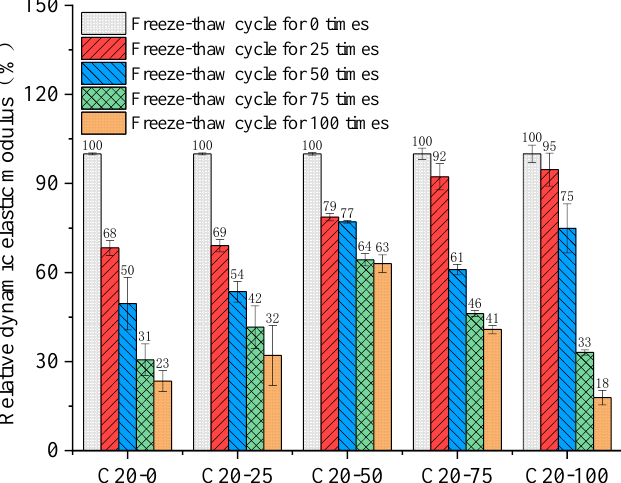
Figure 14. Relative dynamic elastic modulus of C20 concrete under freeze – thaw cycles.